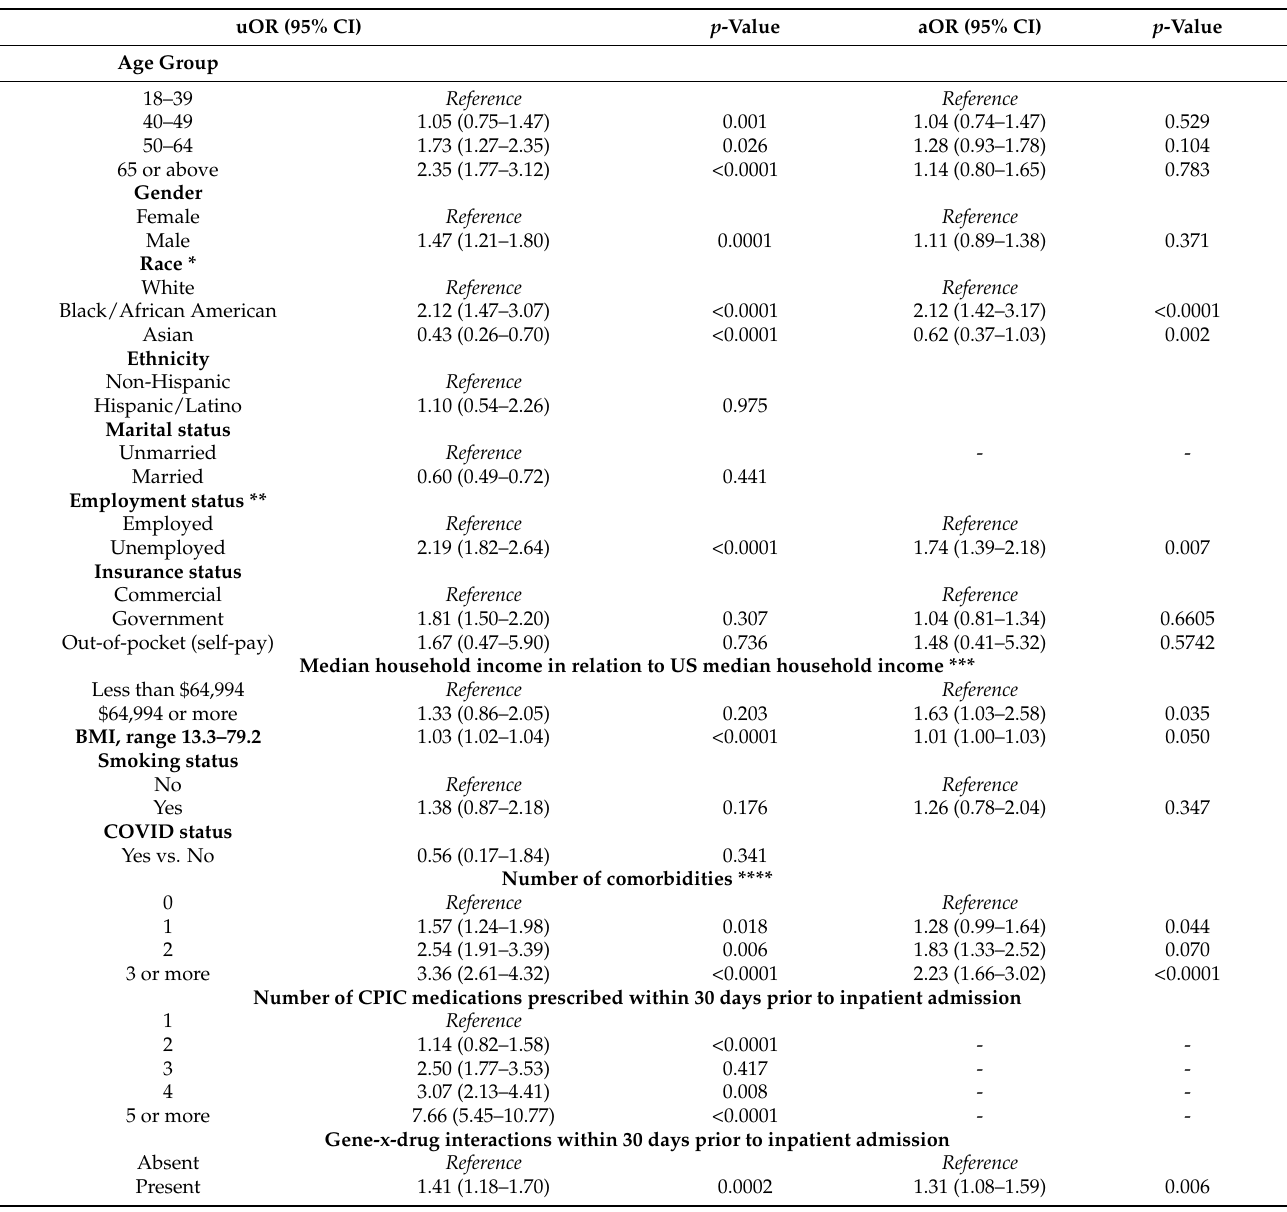
Table 4. Unadjusted and Adjusted Logistic Regression Analysis of 90-day Hospital Readmissions Among Patients Prescribed a CPIC Medication Within 30 days of Inpatient Admission ( n =